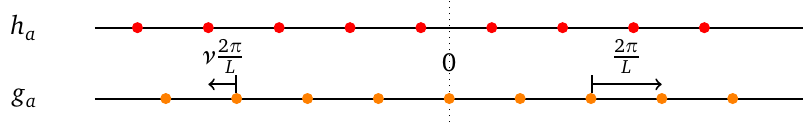
Figure 2: Momentum space picture of unshifted and shifted N = 9-particle ground states | g 〉 and | h 〉 , respectively. g